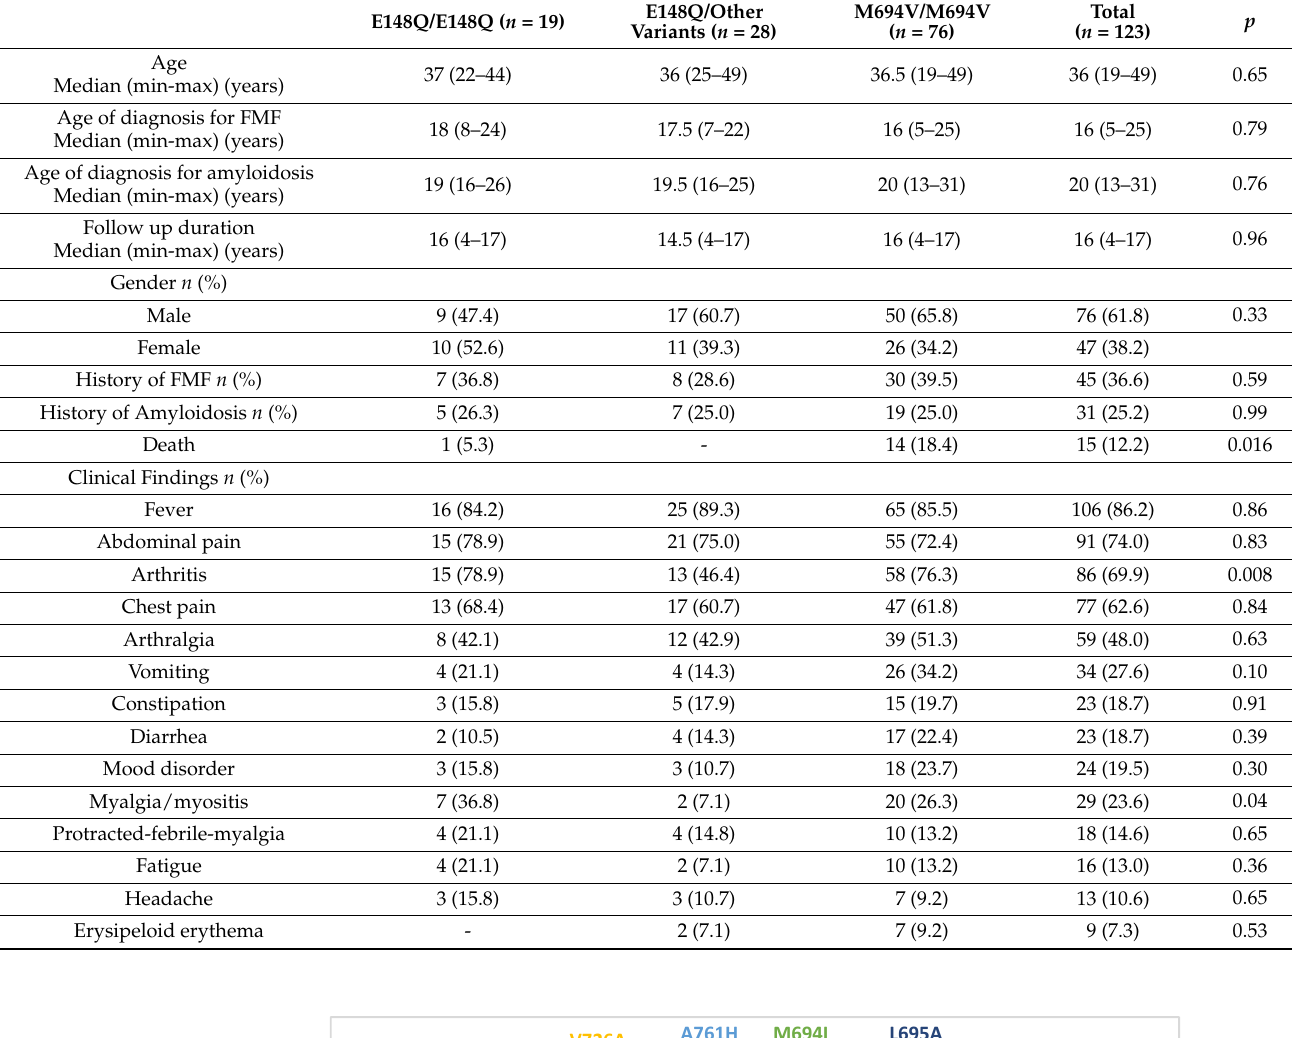
Table 2. Demographic characteristics, clinical findings, kidney biopsy at the time of enrollment, in patients with FMF-related renal amyloidosis, and their comparison according to E148Q and M694V genotypes.